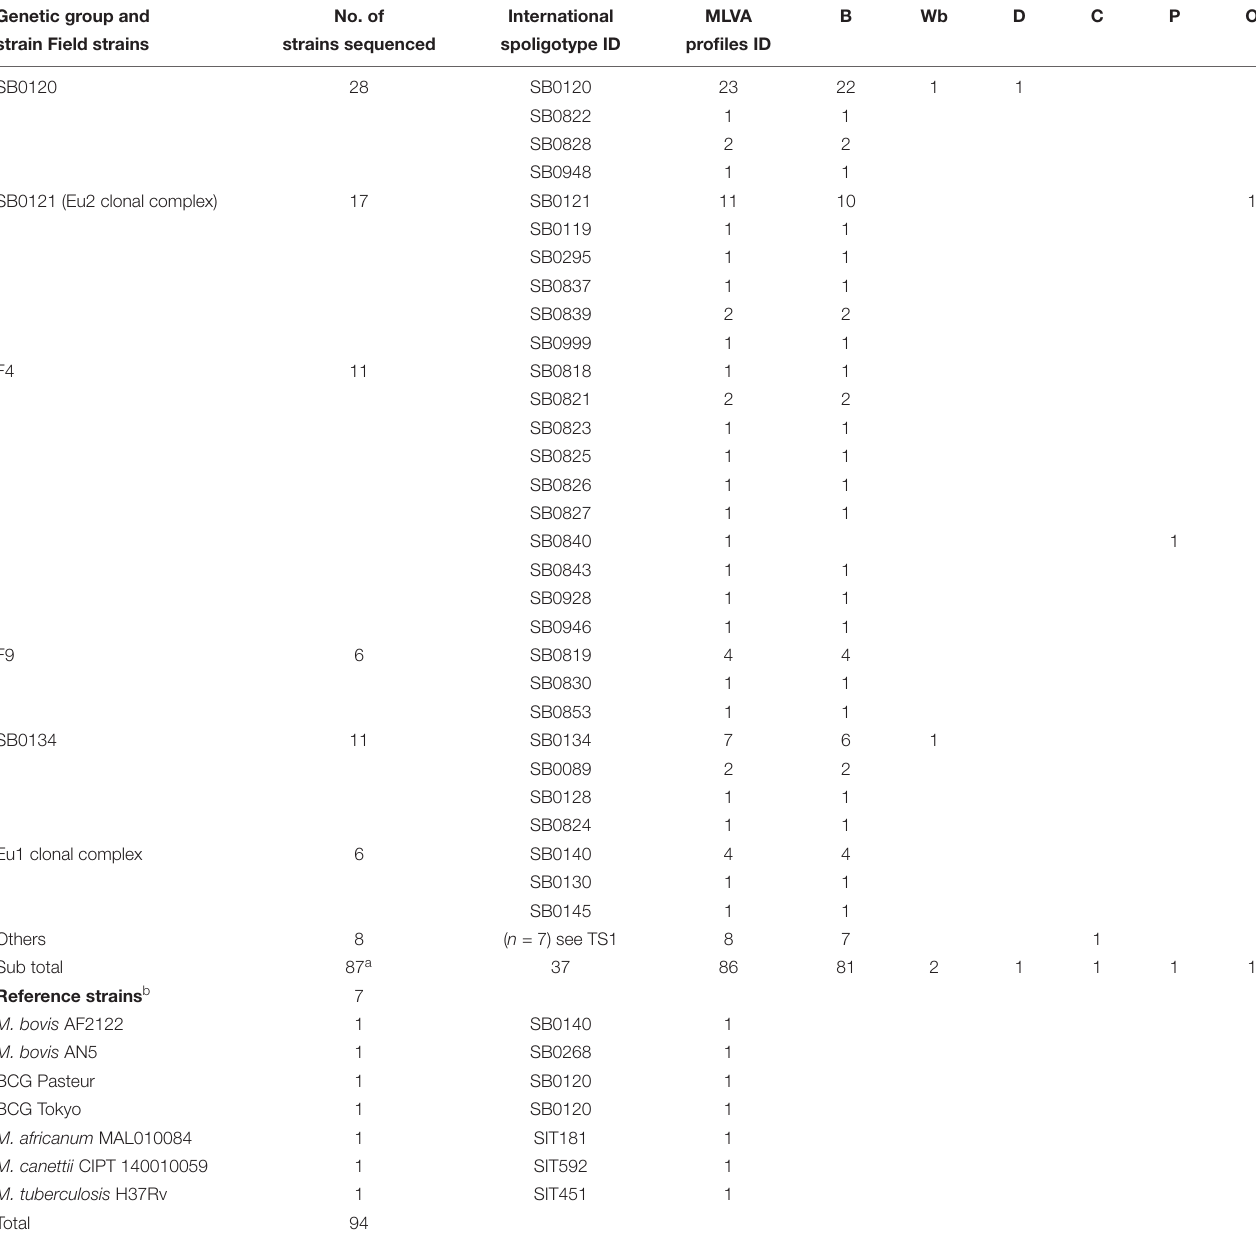
TABLE 1 | Details on strains used in this